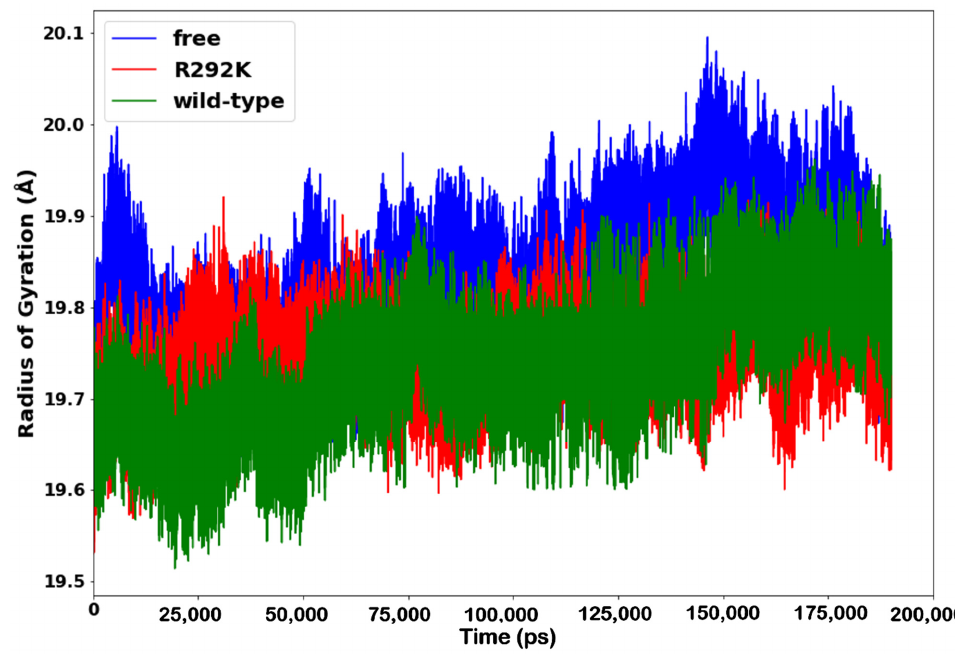
Figure 5. Radius of gyration plot of C- α atoms of the peramivir-free enzyme and peramivir–wild-type, and peramivir–R292K neuraminidase complexes over the simulation time (ps).